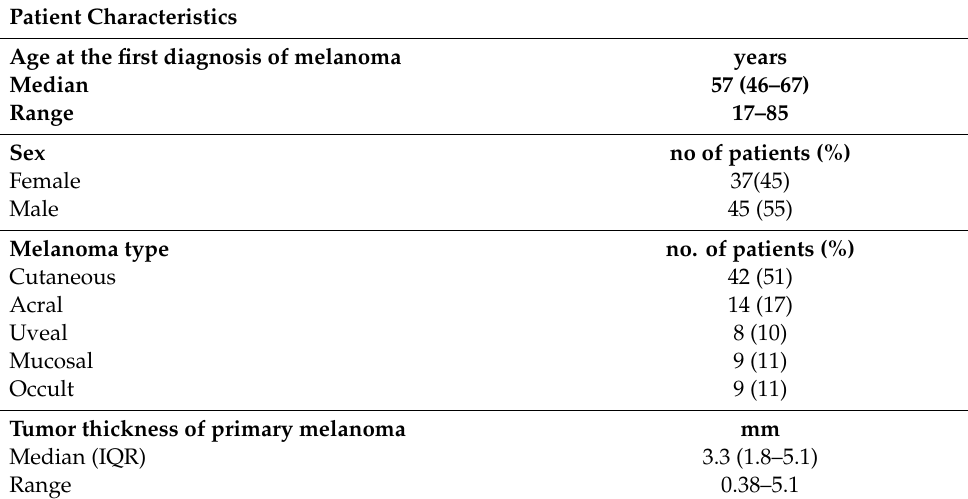
Table 1. Clinical characteristics of the 82